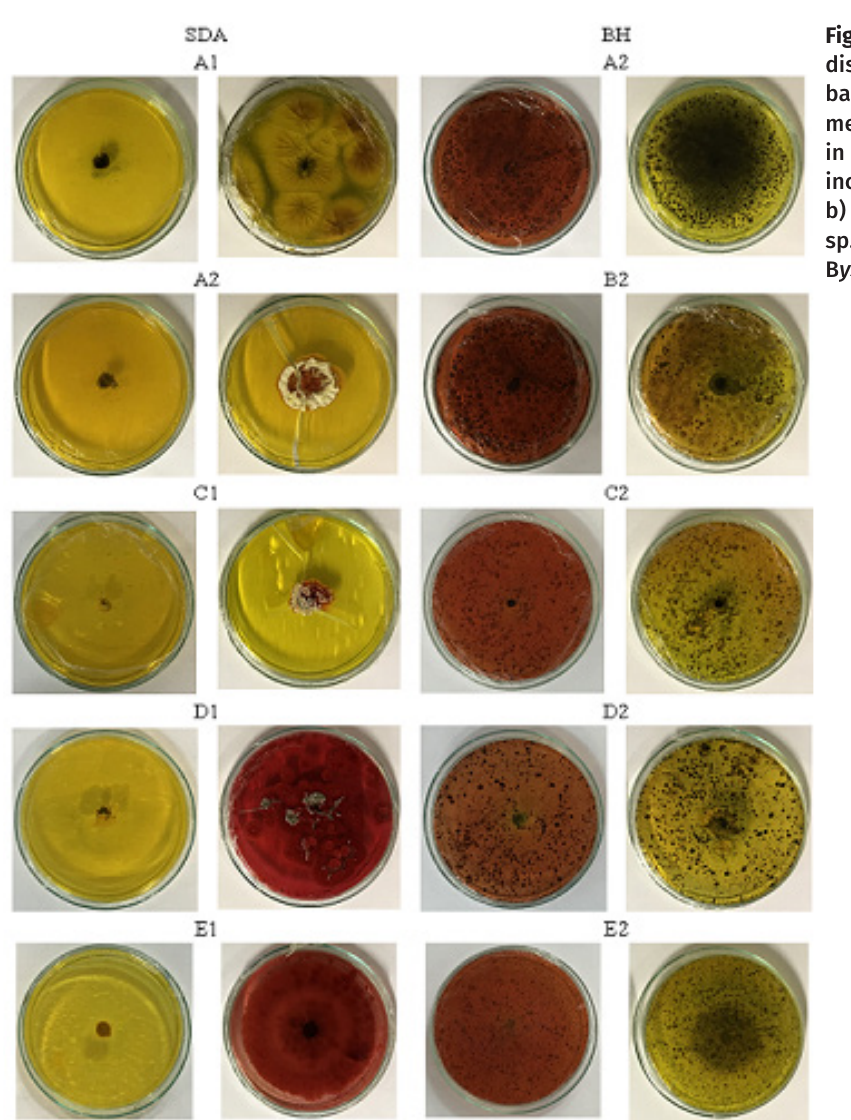
Figure 1. Phenol red discoloration halo seen from back by fungal strains in SDA medium (1) and BH medium (2) in 1 day and after 15 days of incubation. a) Aspergillus